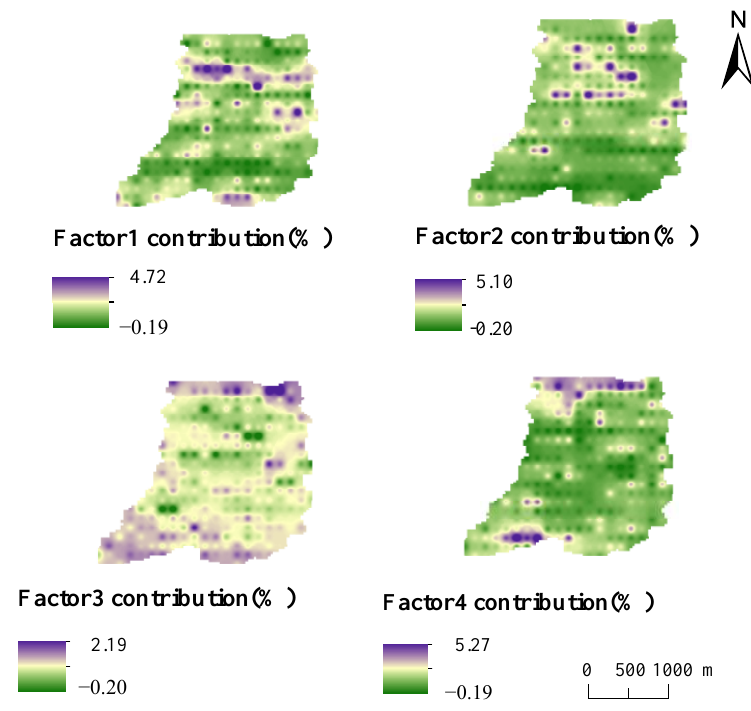
Figure 7. Spatial distribution of PMF source contribution.